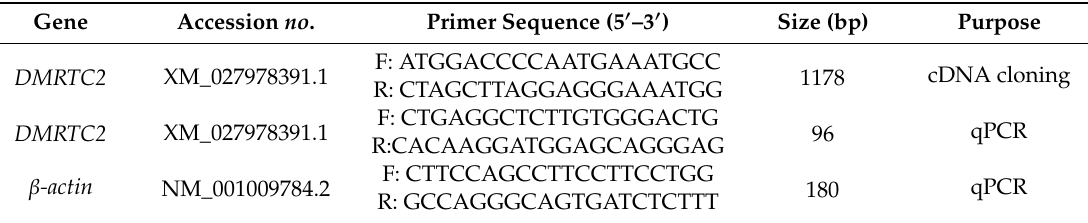
Table 1. List of the primers used in this